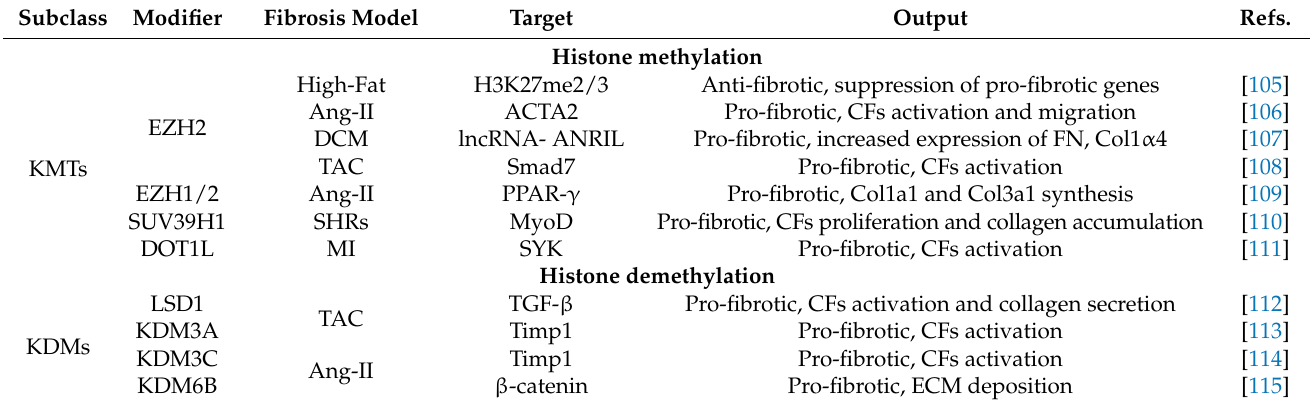
Table 3. The roles of histone methylation modifiers in CFs activation and cardiac